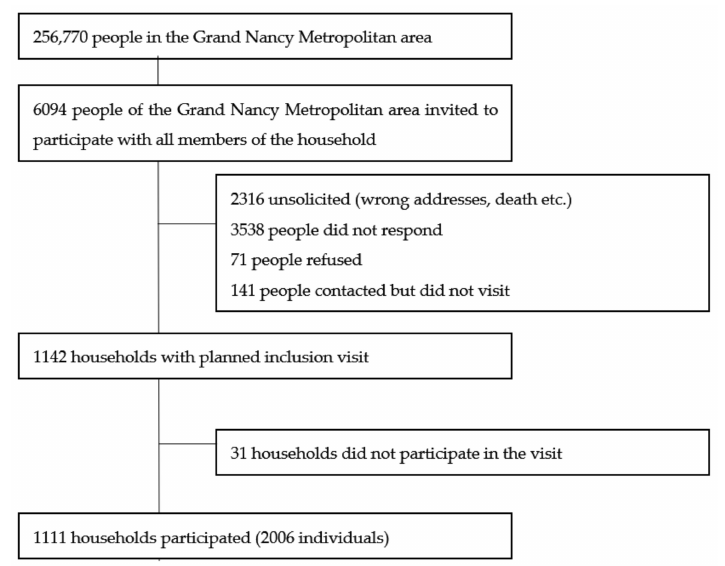
Figure 2. Flow of participants in the study.